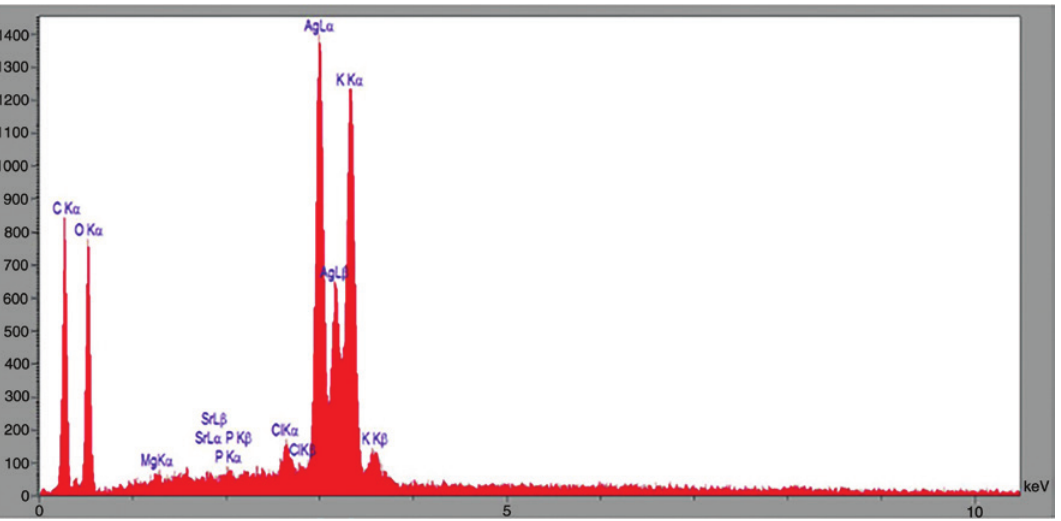
Figure 4: Energy dispersive X-ray (EDX) spectrum of silver nanoparticles colloid.